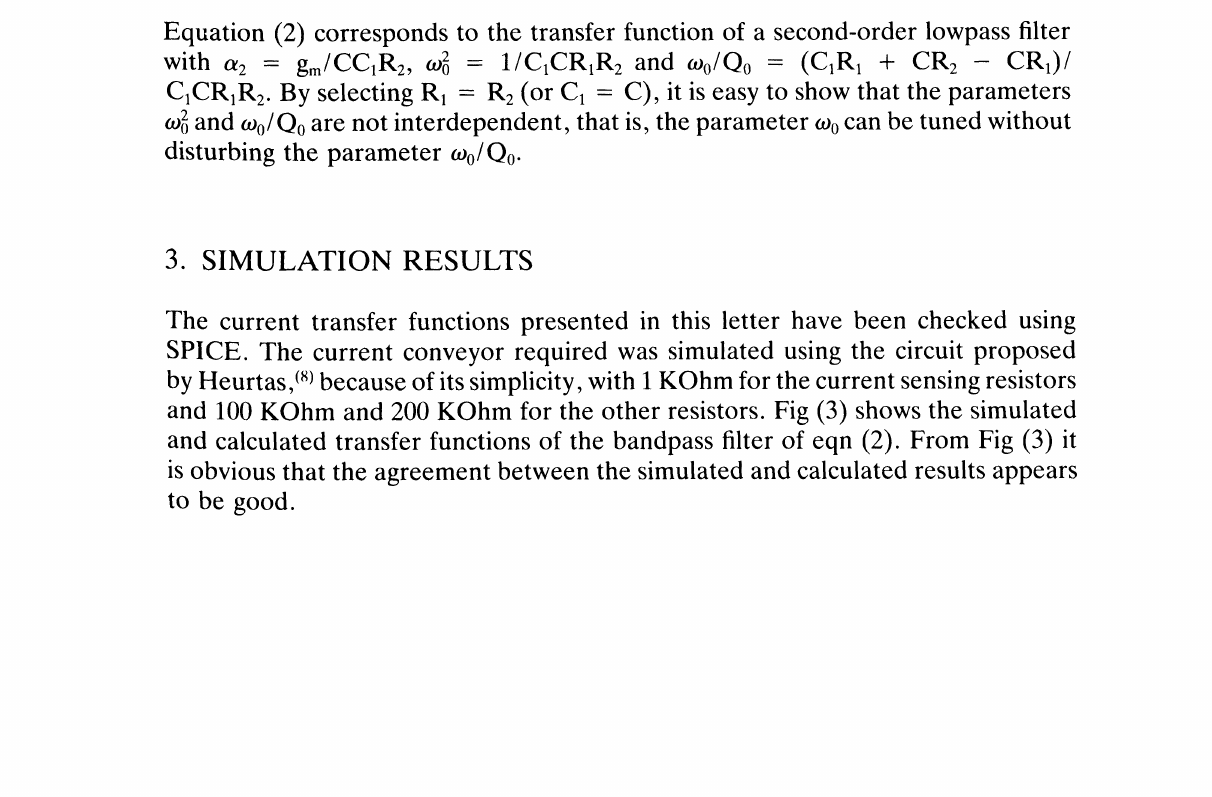
FIGURE 2 Proposed lowpass